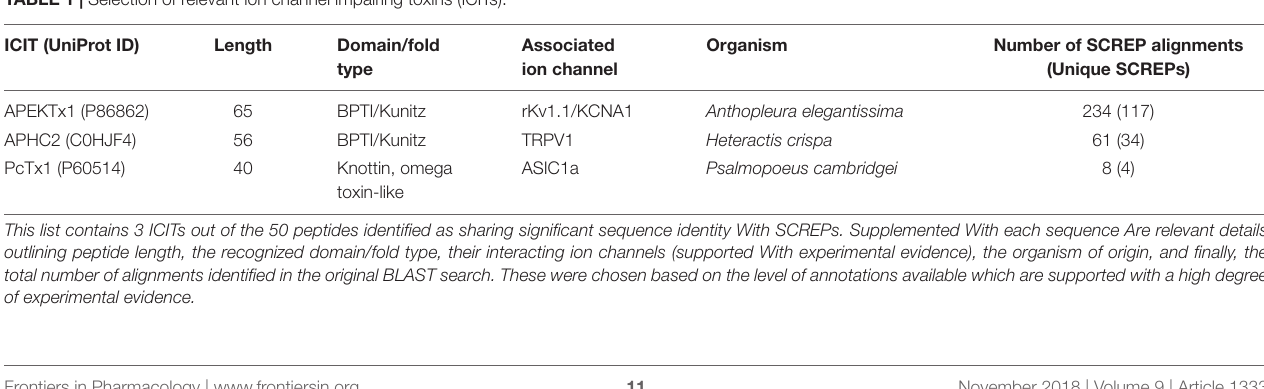
TABLE 1 | Selection of relevant ion channel impairing toxins